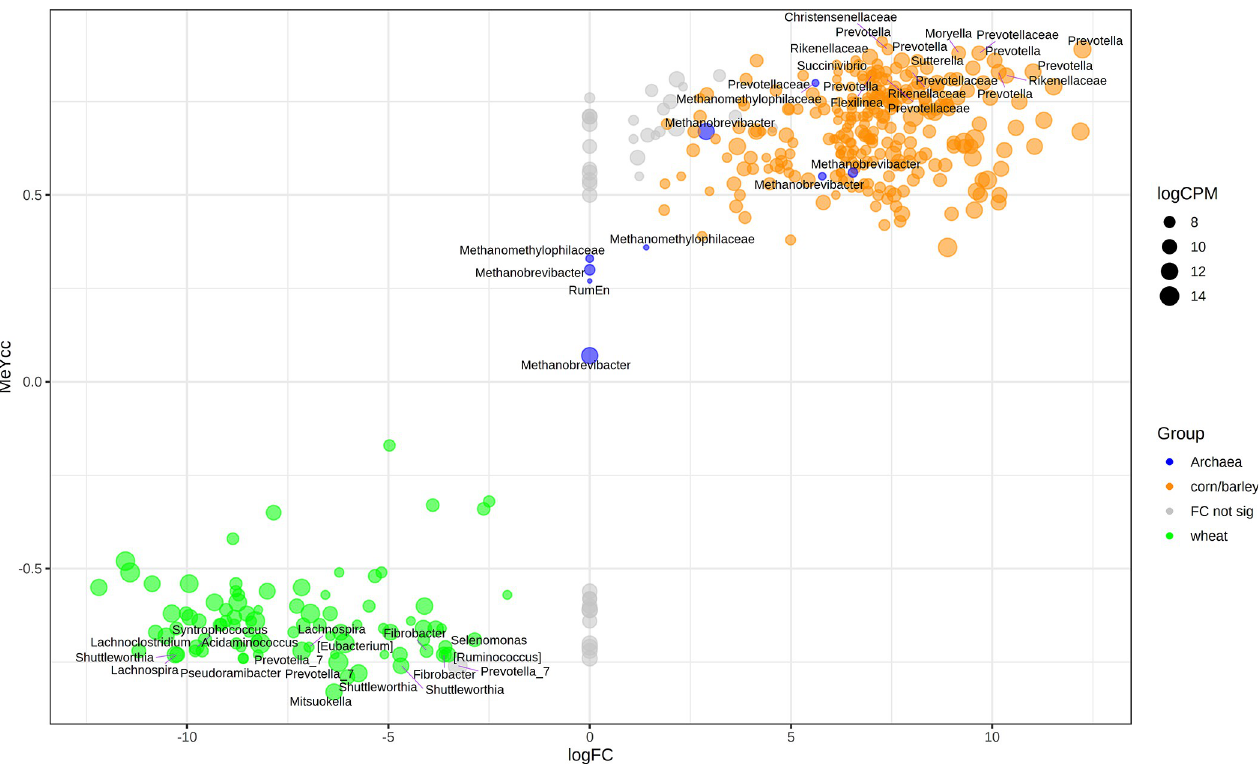
Fig 4. Differential abundance of OTU: Non-wheat vs wheat + MeY. Volcano scatter plot of the result of the Spearman Rank Correlation vs the edgeR differential abundance analysis contrasting wheat diet rumen OTU vs non-wheat. Y axis = methane yield (MeY) correlation, X axis = log2 fold change (logFC). Shown are the bacterial OTU where the P -value for the MeY correlation was less than 0.001 and mean abundance at least 128cpm. All archaeal OTU are shown. Grey discs represent OTU where the abundance change between diets was not significant (false discovery rate > 0.02). For ease of visualisation genus labels are shown only for OTU near the extremities of the plot or to highlight certain taxa such as the archaea.